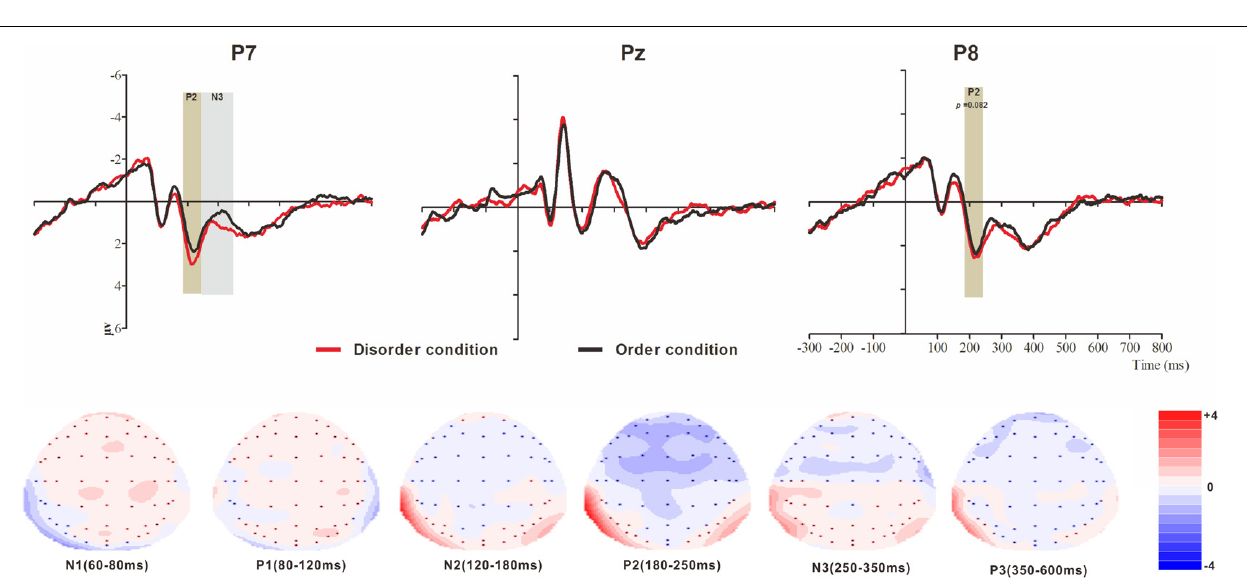
FIGURE 5 | Top: Average ERP waveforms at posterior P7, Pz, and P8 electrodes elicited by centrally presented physical environment disorder (red line) or order (black line) pictures. The significant differences between the disorder and order conditions are indicated by the gray (negative differences) and earthy yellow (positive differences) rectangles, respectively. Time = 0 ms indicates the stimulus onset. Bottom: Topographic maps of the mean voltage amplitudes for the difference waveforms (disorder condition minus order condition) matched to the time window of each component elicited by the stimuli (notably the posterior locations). Increased negativity is shown in blue, and increased positivity is shown in red.